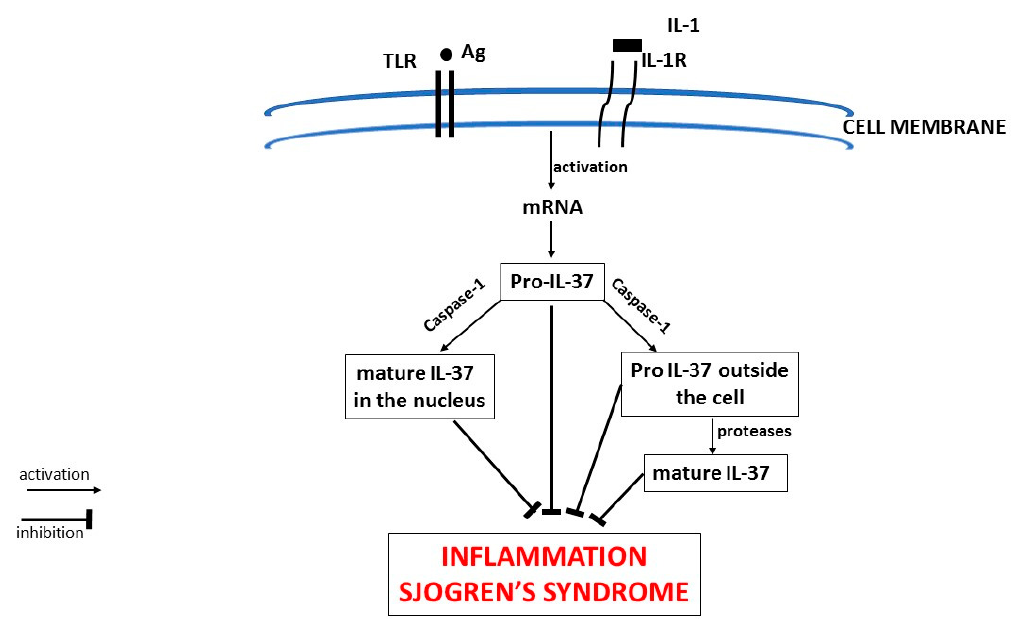
Figure 3. The antigenic activation of Toll-like receptor (TLR) and / or interleukin (IL)-1R receptor with IL-1 leads to the generation of IL-1 mRNA with the production of pro-IL-37, which by means of a caspase-1 causes the release of IL-37 mature in the nucleus. Outside the cell, pro-IL-37 reacts with an unknown protease to produce the mature IL-37. Both, pro-IL-37 and the mature form are active in inhibiting inflammation in Sjogren’s syndrome. Here we confirm the anti-inflammatory activity of IL-37 in several diseases, including Sjogren’s syndrome. TLR: Toll-like receptor; IL: interleukin; mRNA: messenger ribonucleic acid; Ag: antigen.